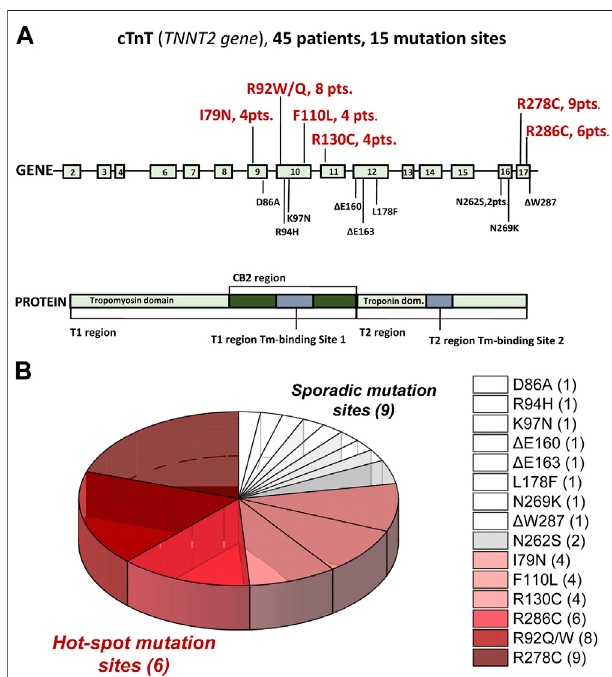
FIGURE 1 | Sites and carrier numerosity of individual mutations in 45 TNNT2 -positive Hypertrophic CardioMyopathy patients (HCM). (A) Representationof TNNT2 exons(toppanel)andstructuralandfunctionalcTnT protein domains (bottom panel) showing hot (big red bold numbers) and sporadic (small black numbers) mutation sites. For mutations carried by more than one patient, the total number of carriers is indicated. (B) Pie chart of data reported in A: Six hot-spot mutation sites and nine sporadic ones are identi fi ed. Data modi fi ed and updated from Coppini et al., 2014.